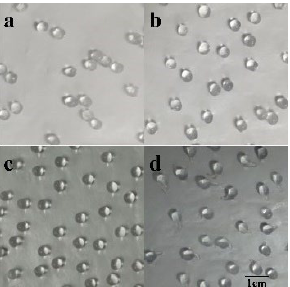
Figure 8. The immobilized enzyme morphology as a function of sodium alginate %-age. ( a ): 1.0% ( b ): 2.0% ( c ): 3.0% ( d ): 4.0%.